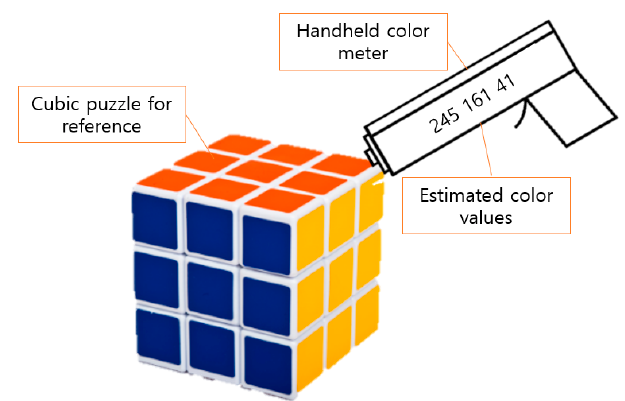
Figure 10. Real cubic puzzle (or cube) provided as a basis for the color comparison. The color values for the reference were measured in advance through a color meter.